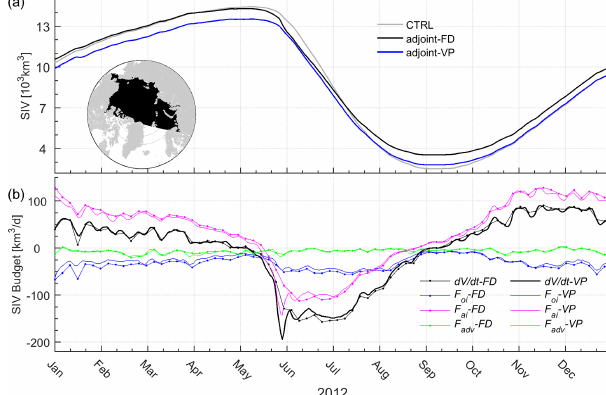
Figure 9. (a) SIV changes in the Arctic Ocean (see the bottom left subplot in a ) from January to December 2012. (b) SIV tendencies and contributions from F oi , F ai , and F adv in adjoint-FD and adjoint- VP (see the legend).